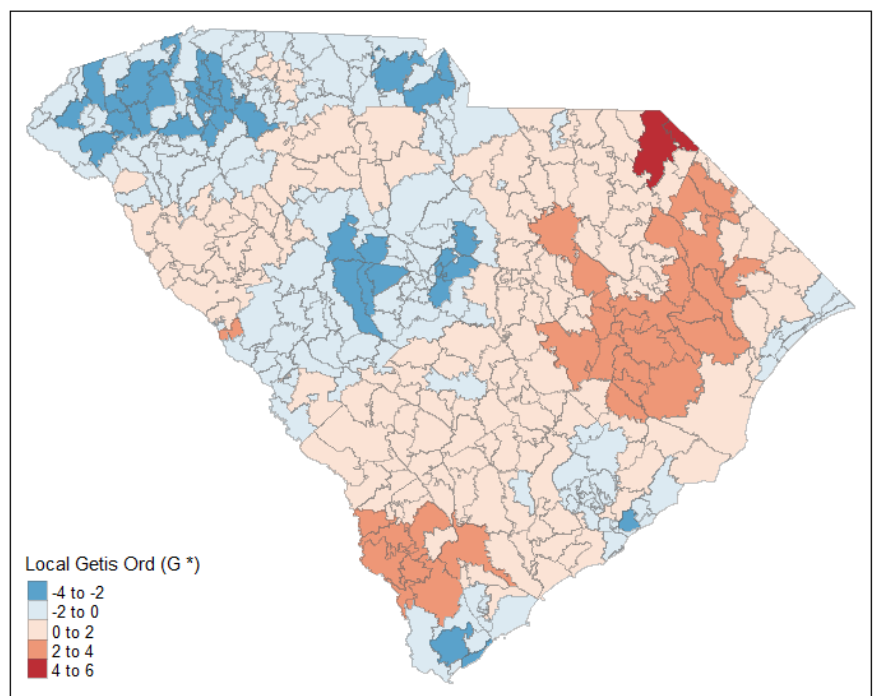
Figure 3. Hot spot of estimated readmission prevalence.